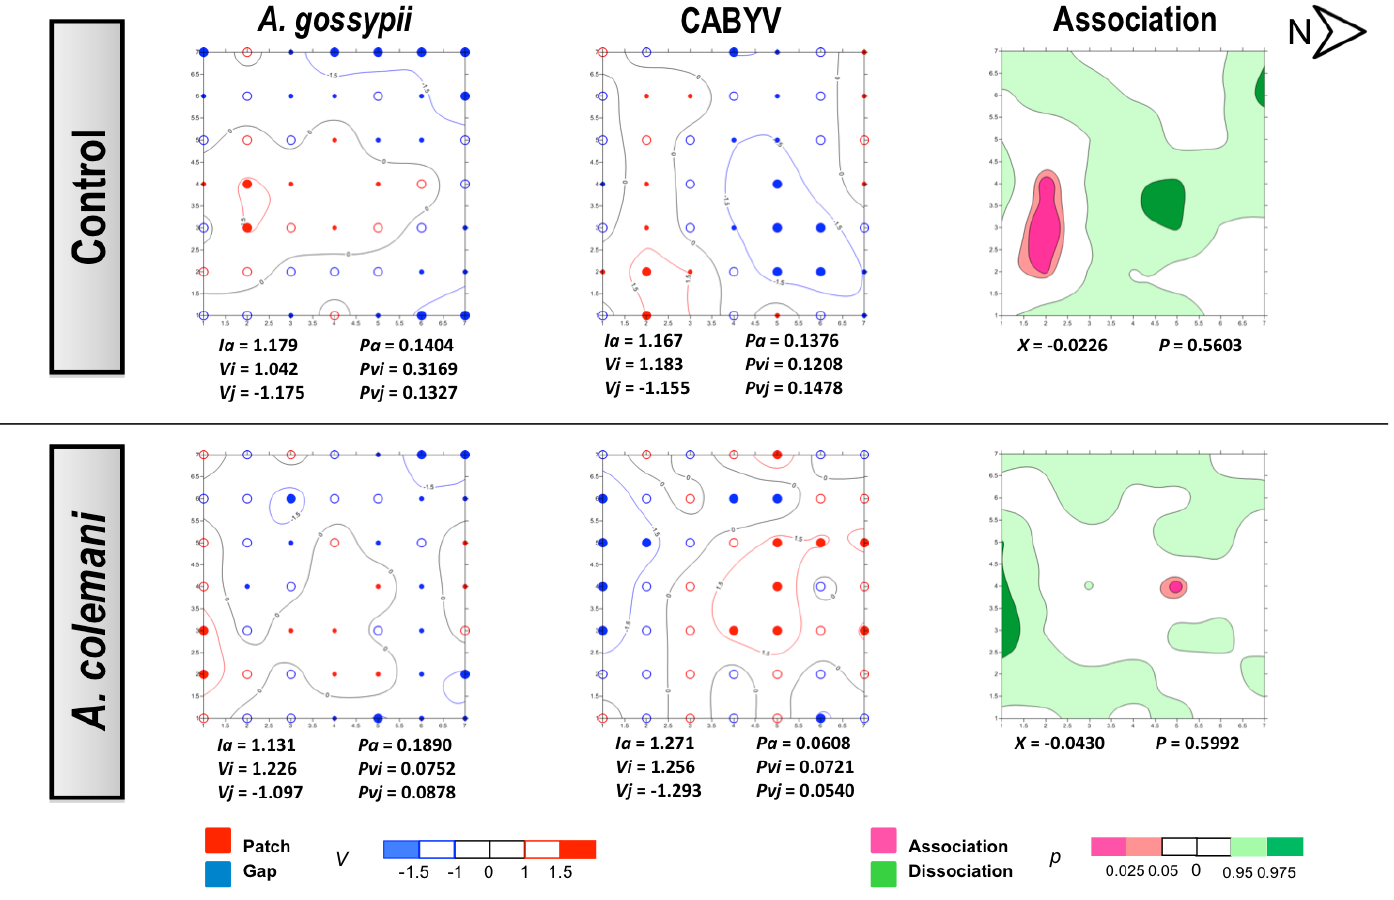
Figure 5. Classed post maps of the spatial distribution of mean number of A. gossypii and cumulative number of CABYV-infected plants (total number of infected plants per treatment) at 7 days, and contoured map of the association between CABYV-infected plants and its vector, A. gossypii . Symbols and contours are as for Figure